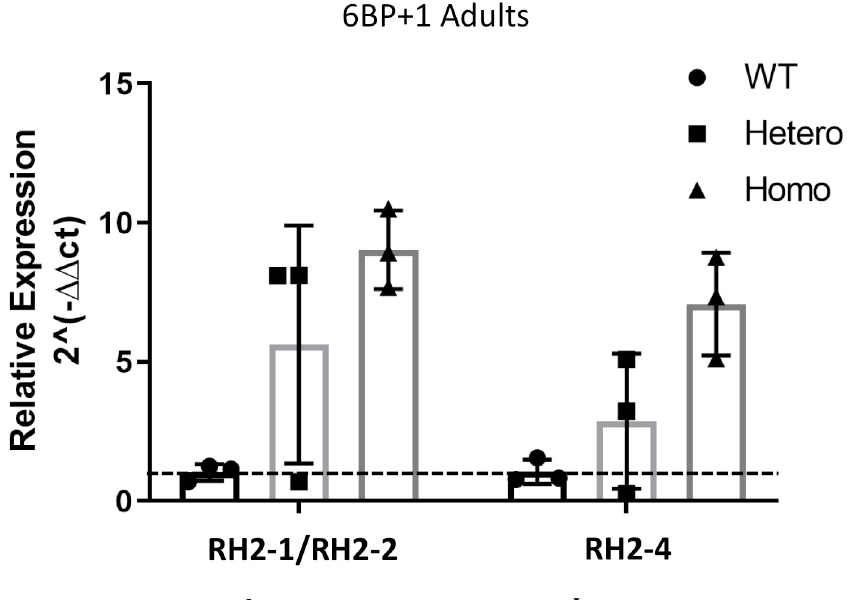
Fig 16. RT-qPCR Analysis. The expression levels of combined RH2-1/RH2-2 and RH2-4 were compared between 6BP + 1 wild types (N = 4), heterozygotes (N = 4), and homozygotes (N = 4). The y-axis displays the fold change as compared to wild types, where the mean is set to 1 (dashed line). The x-axis displays the genotypes and opsin types. The expression levels are normalized to the wild type. The experiment was performed twice, each with 3